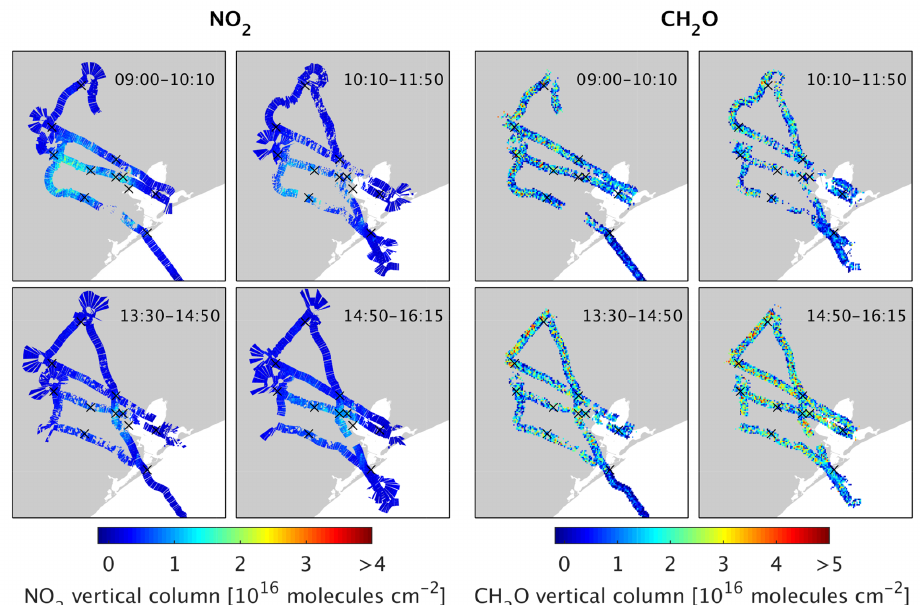
Figure 3. Tropospheric NO 2 and CH 2 O vertical columns measured by GCAS over Houston on 24 September 2013. NO 2 observations are at ∼ 250m × 500m resolution, and CH 2 O columns are at 0 . 01 ◦ × 0 . 01 ◦ ( ∼ 1km 2 ) resolution. Times are local time. Black crosses indicate ground sites.